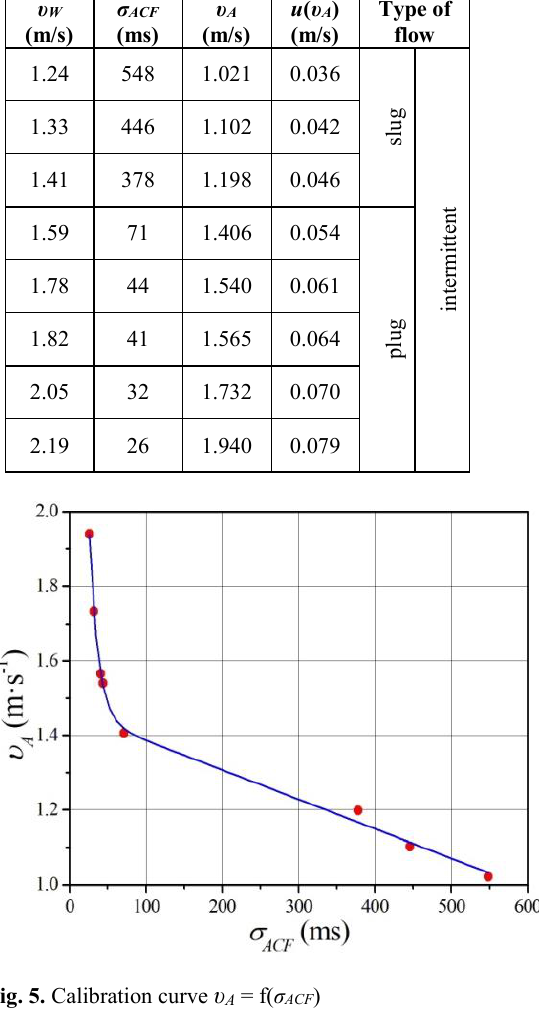
Table 1. Obtained results of experiments: υ W - water velocity.